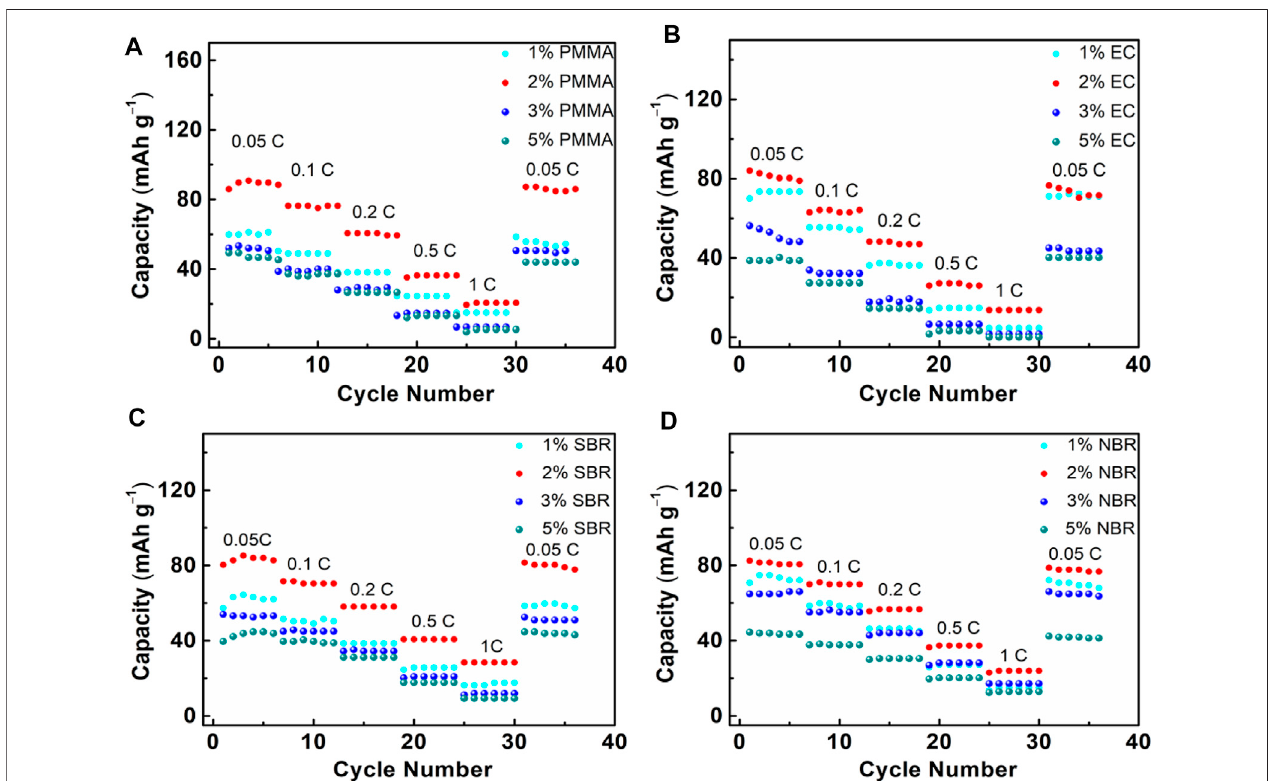
FIGURE 5 | Rate performance of cathode composites with different amount of binder (A) PMMA, (B) EC, (C) SBR, and (D) NBR.